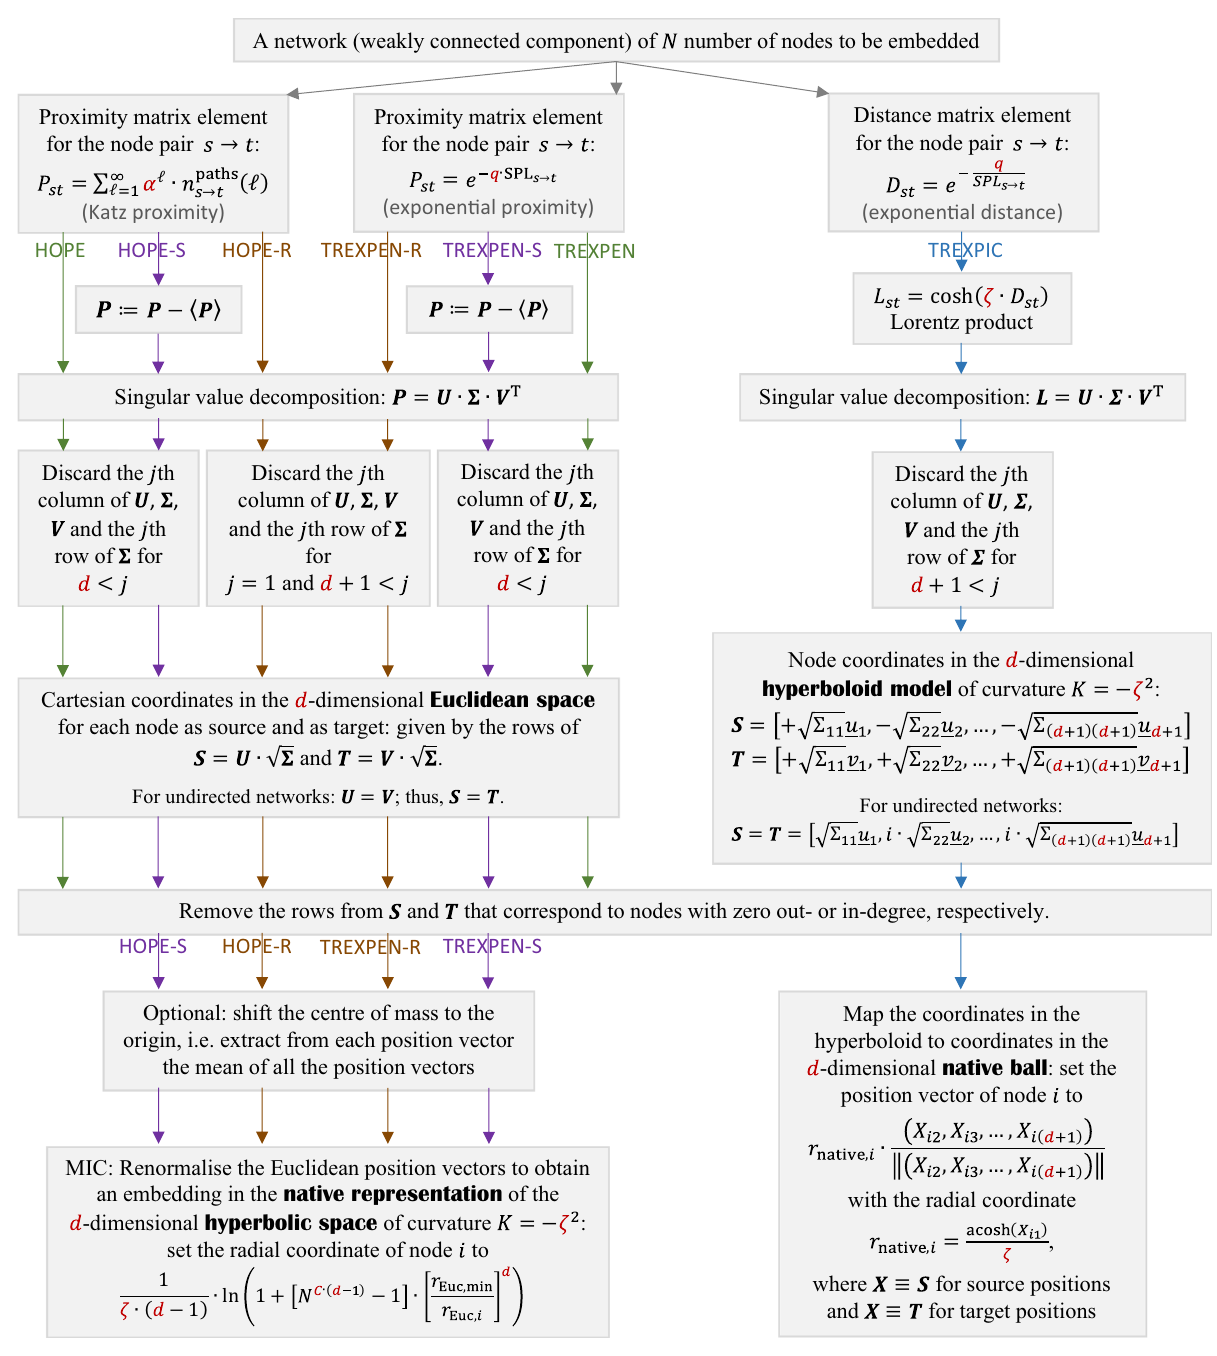
Fig. 1 Flowchart of the studied embedding algorithms. The left side of the fi gure traces the algorithmic steps for creating a hyperbolic embedding with the High-Order Proximity preserved Embedding (HOPE), our TRansformation of EXponential shortest Path lengths to EuclideaN measures (TREXPEN) and their variants by converting the Euclidean node arrangement obtained from them to a hyperbolic one with our model-independent conversion (MIC). The right side of the fi gure shows the algorithmic steps of our method named TRansformation of EXponential shortest Path lengths to hyperbolIC measures (TREXPIC), which embeds networks directly in the hyperbolic space. The embedding parameters are written in red: the parameters α and q adjust how the elements of the reduced matrices depend on the distances measured along the graph to be embedded, d denotes the number of dimensions of the embedding space, ζ (usually set to 1) tunes the curvature of the hyperbolic space, and C (usually set to 2) controls the extent of the graph in the hyperbolic space when using